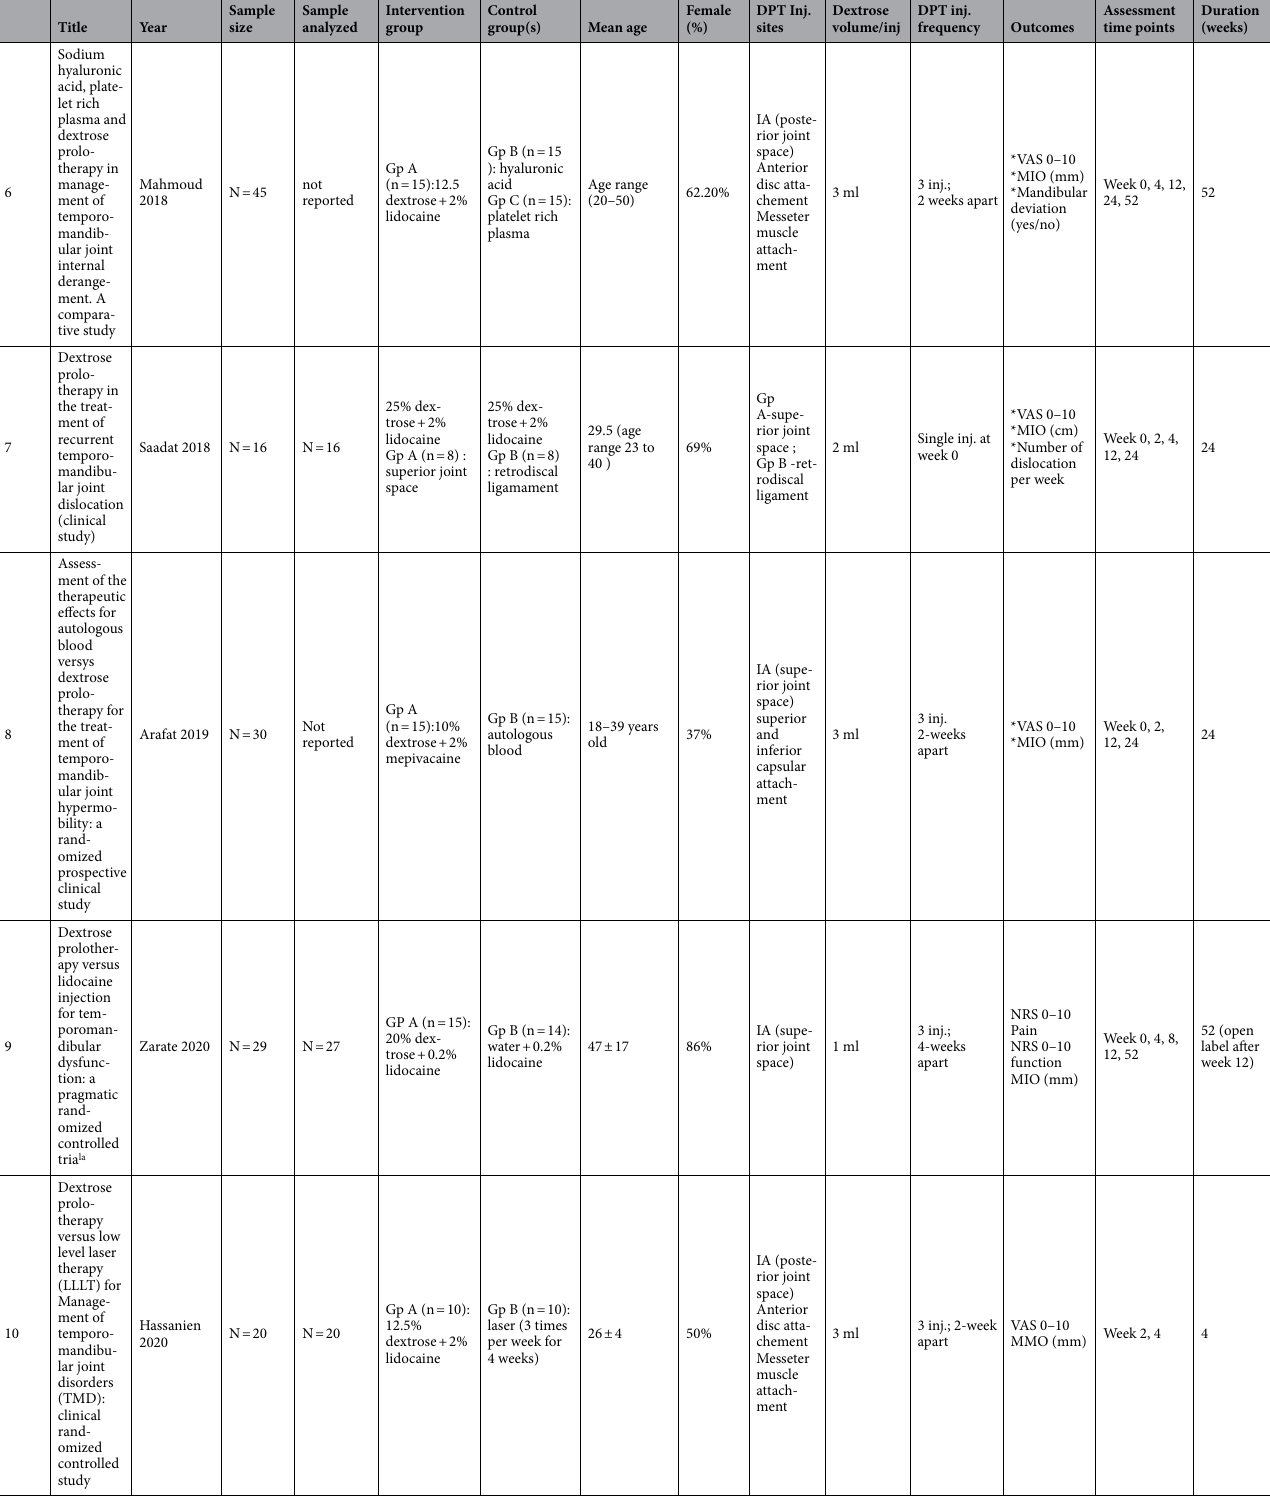
Table 1. Study characteristics table. Gp group, DPT hypertonic dextrose prolotherapy, IA Intra-articular, VAS visual analog scale, NRS numerical rating scale, MIO maximum incisor opening, MM minimeter, NS normal saline. *Raw figures not